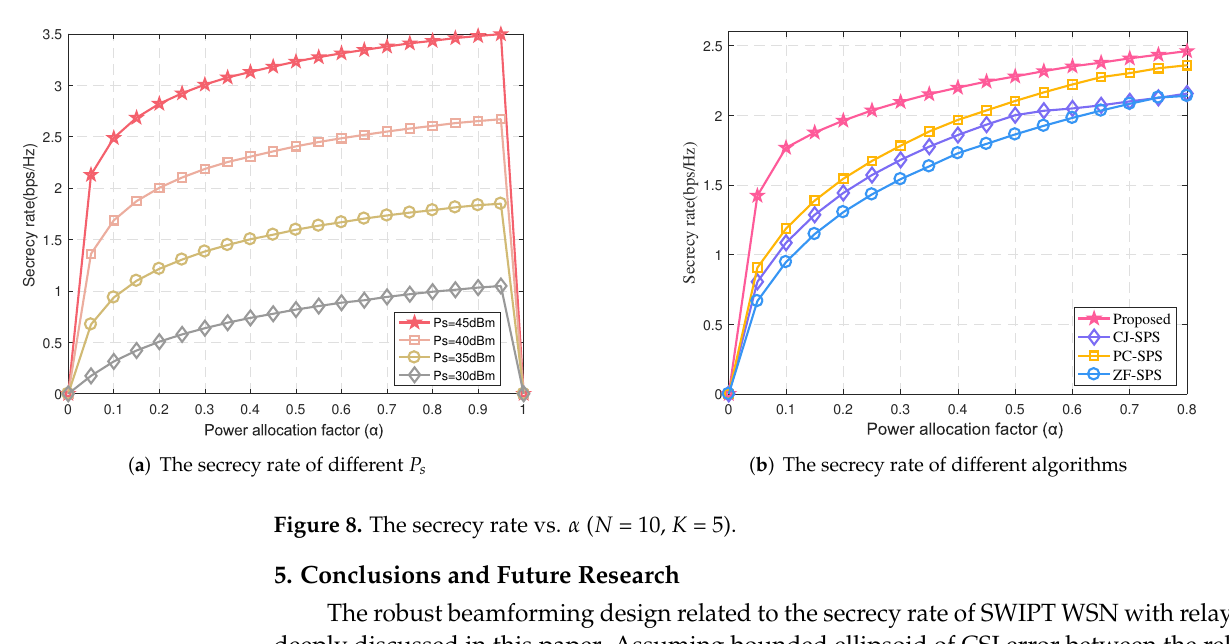
Figure 7. The secrecy rate vs. the number of relays ( K = 1).